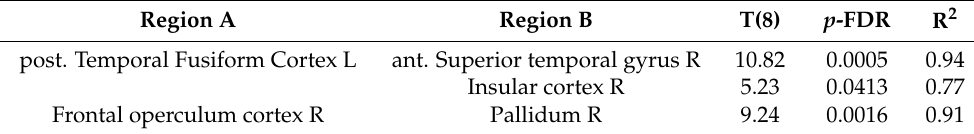
Table 3. Functional connectivity changes following Fr-PCA therapy with initial aphasia severity as a